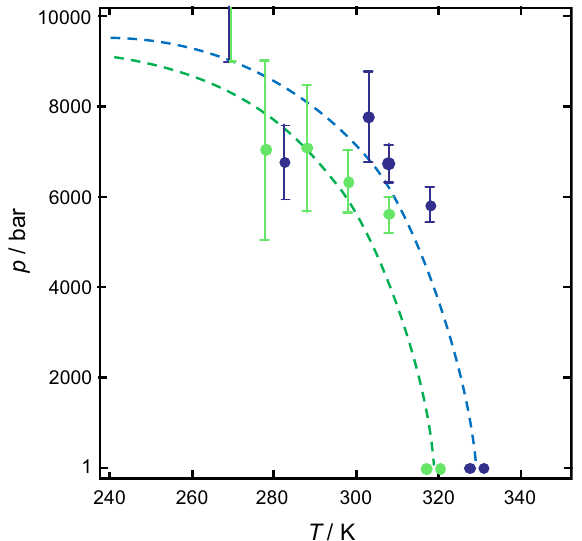
Figure 5. Pressure–temperature stability diagram of α-chymotrypsin. The pressure–temperature stability diagram of α-chymotrypsin in pure buffer (blue data points and dashed line) and in 0.25 M Mg(ClO 4 ) 2 (green data points and dashed line). Calculated data (dashed lines) were derived from the contours of the Gibbs free energy of unfolding at ∆ G = 0 [Eq. (6)]. Data points indicate measured values at different temperatures and pressure obtained from FTIR spectroscopy (at ambient and high pressure) or DSC (at 1 bar). Error bars show the maximum error and are derived from at least two independent measurements, N ≥